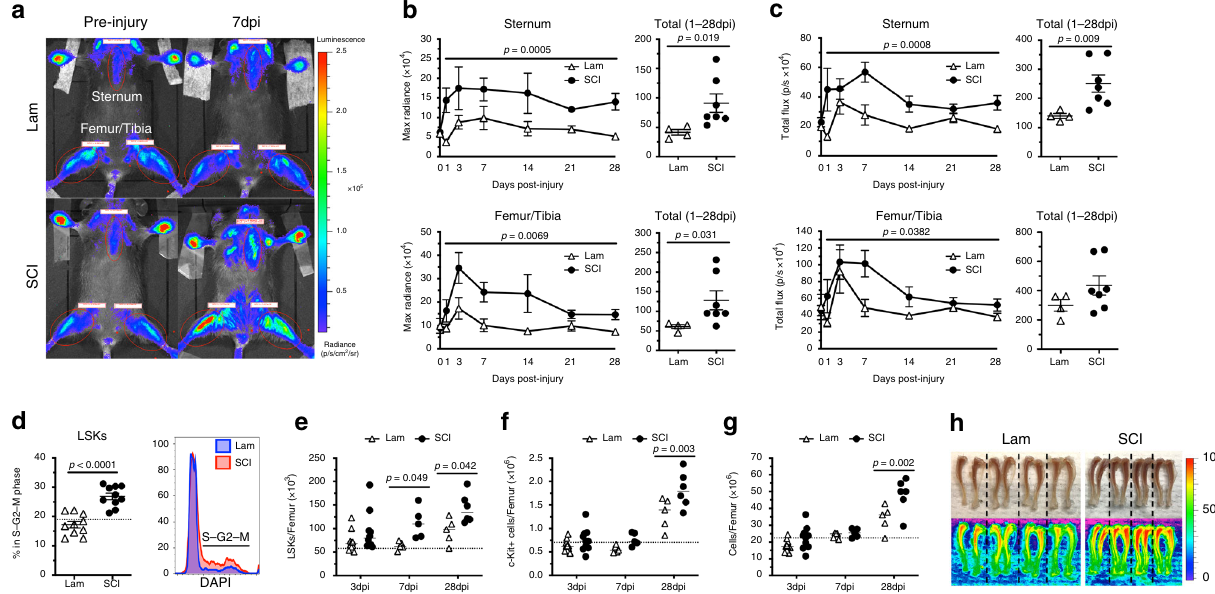
Fig. 1 T3 transection SCI protracts HSPC proliferation and causes HSPC accumulation in bone marrow. a Bioluminescent imaging of sternum and femur/ tibia regions of interest (ROIs; red ellipses) pre-injury and 7 dpi. b , c Bioluminescence expressed as max radiance (peak intensity within ROI) and total fl ux (average intensity within ROI) for each region, with left and right femur/tibia averaged; data also expressed as the total (sum) of signals from 1 to 28 dpi. d Proportion of proliferating lineage low, Sca-1 + , c-Kit + (LSK) bone marrow cells, as indicated by the S – G2 – M phase of the cell cycle, at 3 dpi; representative histograms of LSK proliferation at 3 dpi (closest to the mean). Quanti fi cation of LSKs ( e ), c-Kit + progenitors ( f ), and total bone marrow cells ( g ) at 3, 7, and 28 dpi. h Images and heatmaps of tibia pairs from Lam and SCI mice demonstrating increased optical density (arti fi cial units) corresponding with increased bone marrow cellularity. All data are mean ± SEM, mixed effect model with repeated measures ( b , c ), two-sample t -test ( b – d ), two-way ANOVA with Bonferroni multiple comparisons ( e – g ); n = 4 and 7/group in b and c , n = 10/group in d , n = 10/group (3 dpi), 5/group (7 dpi), and 5 and 6/group (28 dpi) in e – g . Dotted lines represent average data from naïve mice. dpi days post-injury, Lam laminectomy (sham injury). Source data are provided as a Source Data fi le.